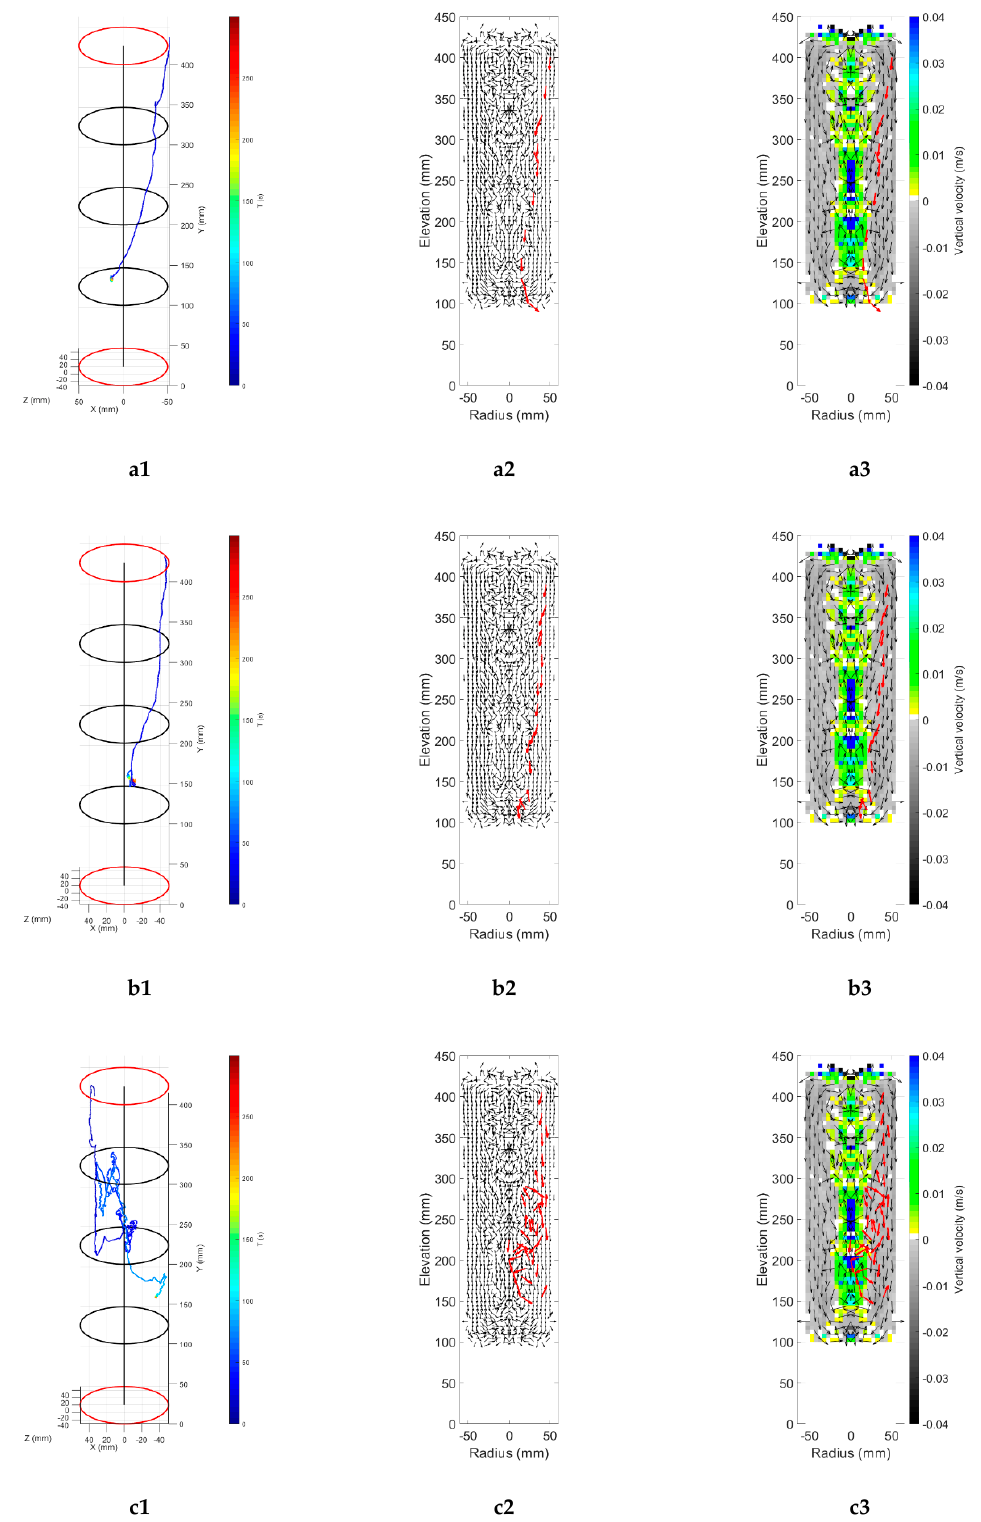
Figure 4. The results of 3 runs ( a – c ) of − 300 + 212 µm hematite particle for an airflow rate of 1.50 u mf (Lagrangian trajectory (1) and Eulerian flow maps (2 and 3)).